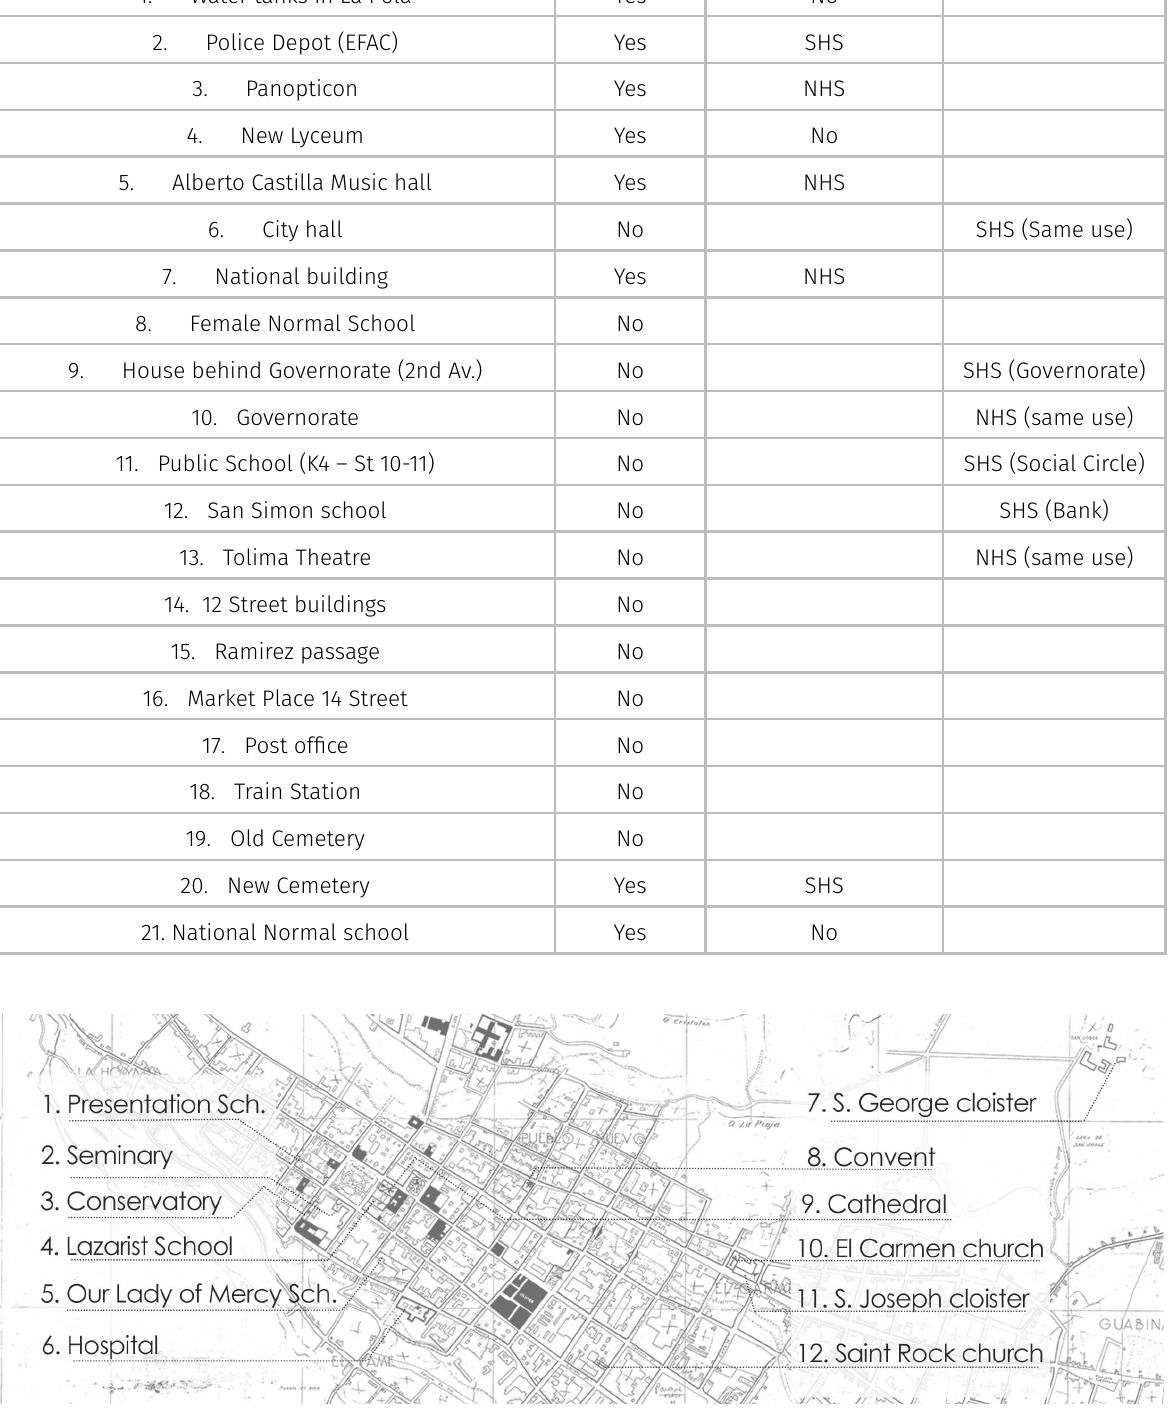
Figure 4. Important buildings in